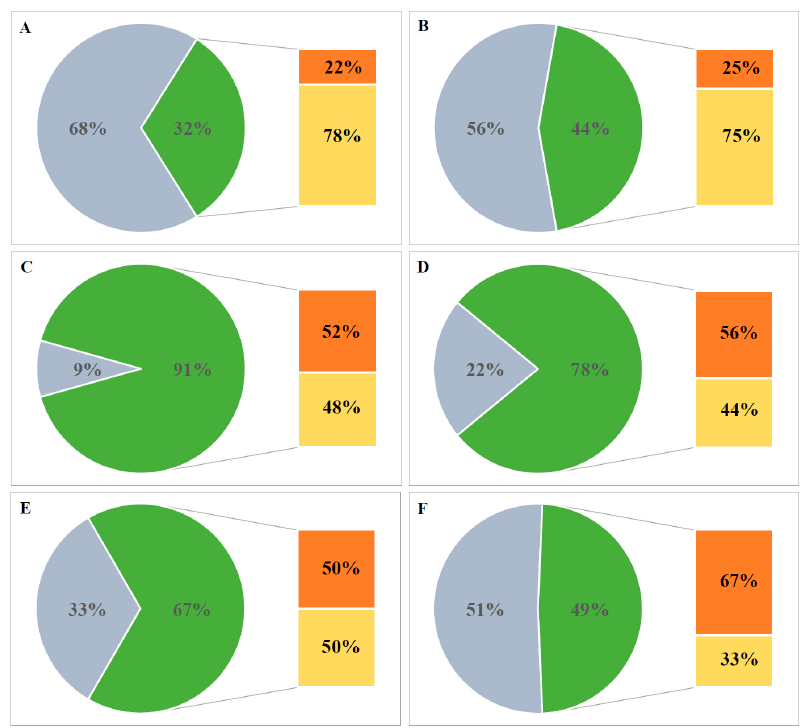
Figure 7. Percentage of strains divided according to habitat-type of origin: ( A ) zoogenic habitat, ( B ) marine habitat, ( C ) glacial habitats, ( D ) pedogenic habitats, ( E ) postglacial habitats, ( F ) freshwater habitats. Percentage of strains positive for granule presence—green part of diagram, negative—gray, constitutive PHA producers within the positives—orange, PIM-inducible PHA producers within the positives—yellow.